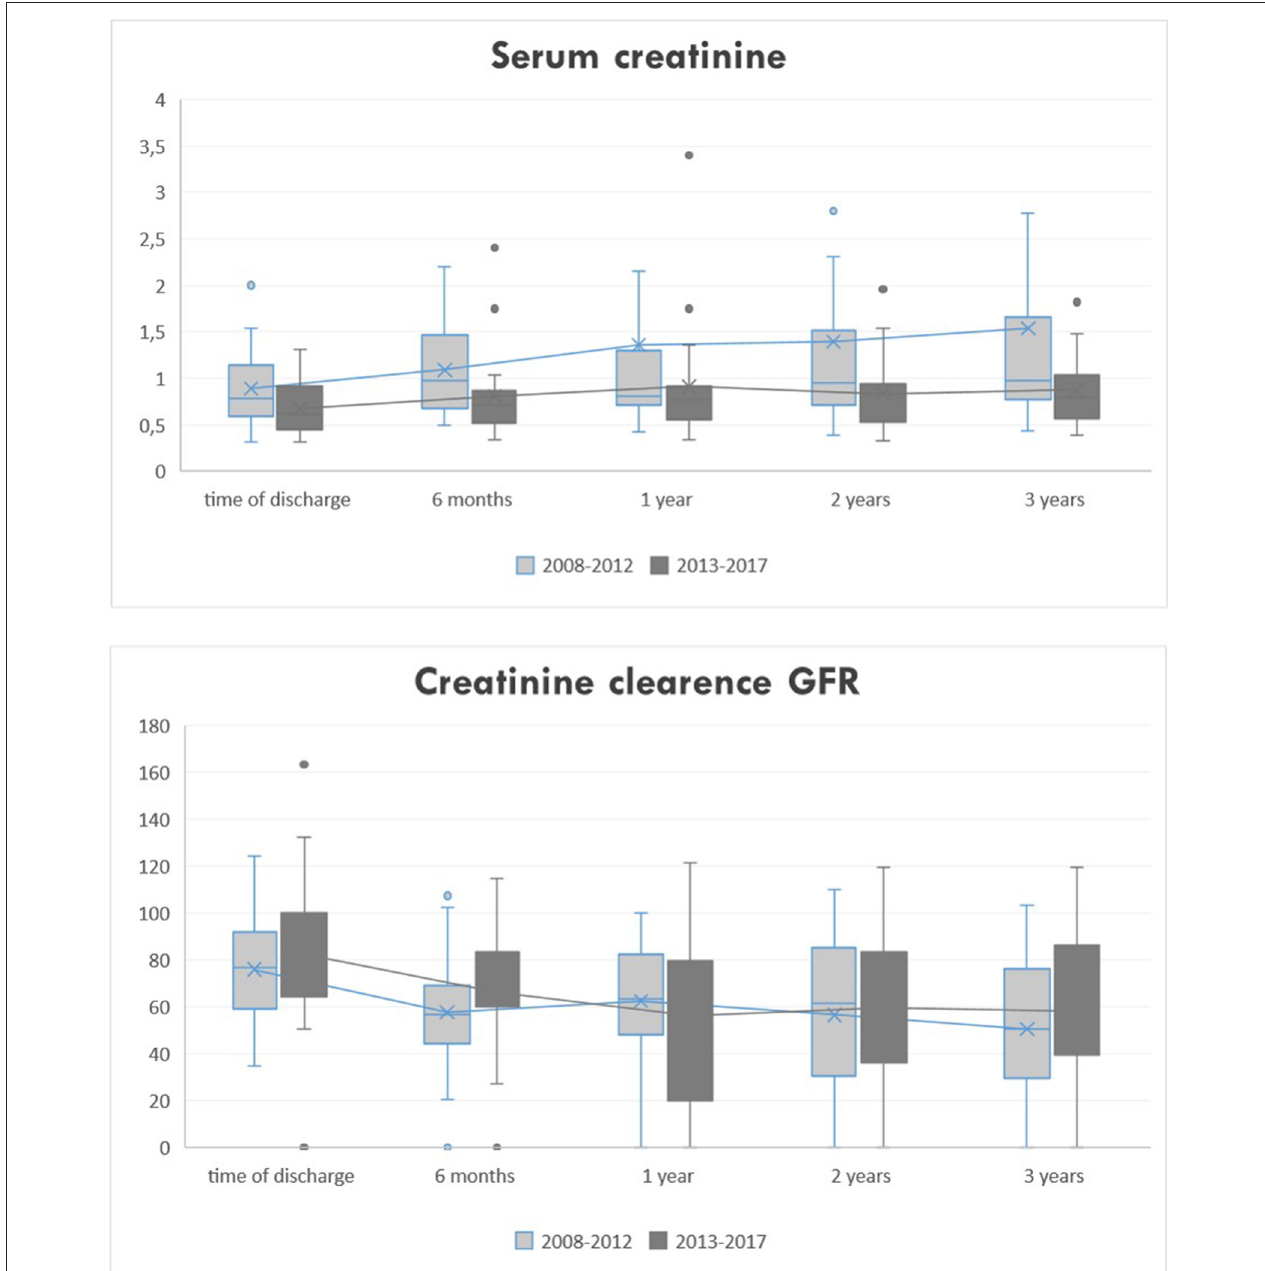
FIGURE 2 | Clinical course of serum creatinine and